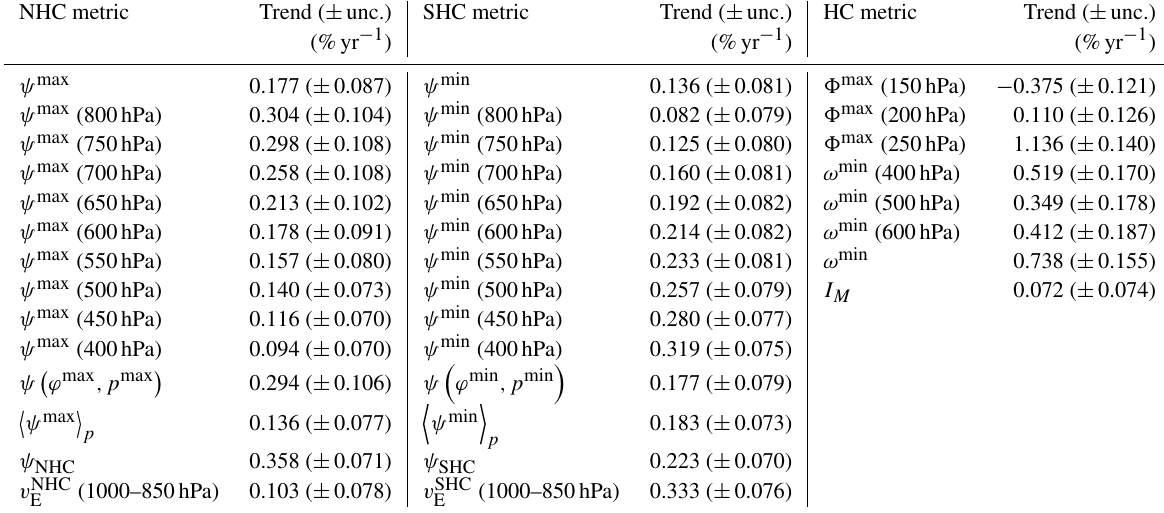
Table 1. Annual-mean HC strength trends normalized by the climatological mean values of HC strength in ERA5 between 1979 and 2018. The trends derived from stream-function metrics (which distinguish between the NHC and the SHC) are separated from the trends derived from other metrics (which describe the two cells together). The values in parentheses denote the standard error of the trend estimates. NHC metric Trend ( ± unc.) SHC metric Trend ( ± unc.) HC